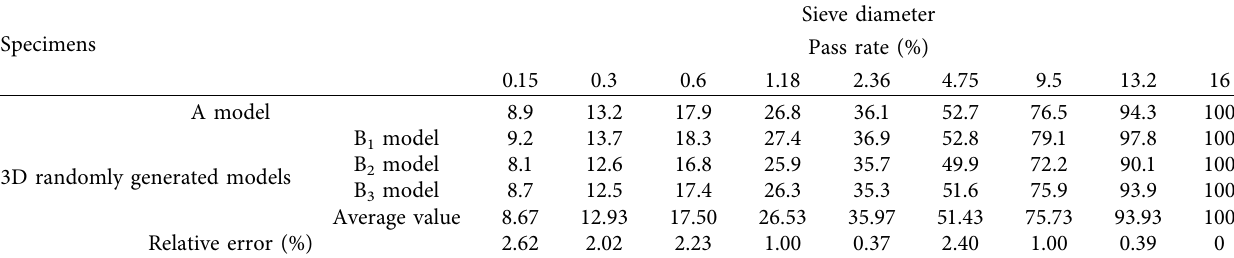
Table 2: Gradation curves of 3D randomly generated models and AC asphalt mixture.